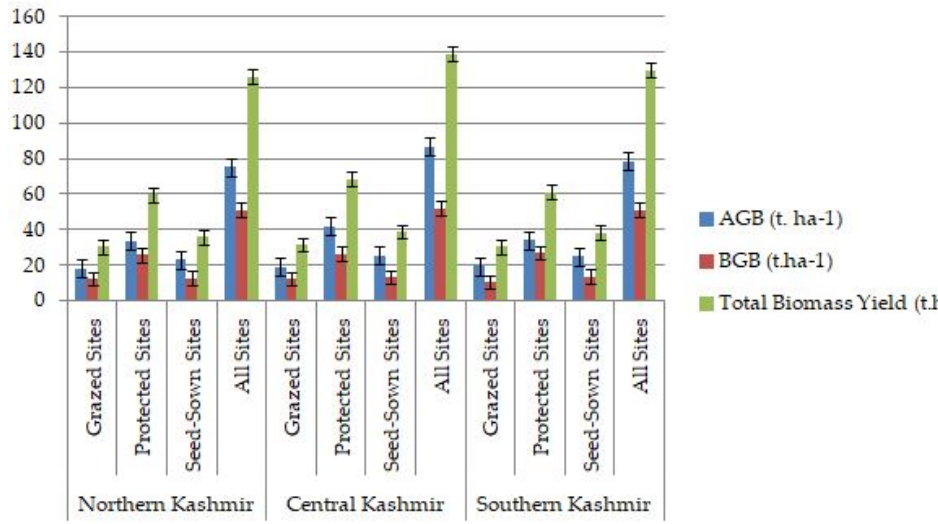
Figure 1. AGB, BGB and total biomass yield (t. ha − 1 ) in studied circles.